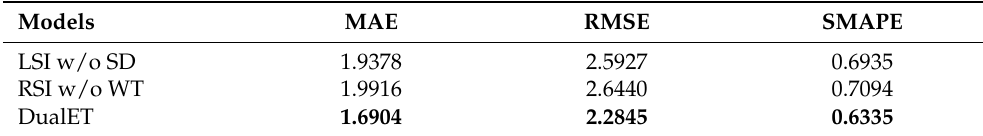
Table 3. Ablation studies of decomposition structures. SD and WT mean the series decomposition block and wavelet transform block, respectively. W/o means